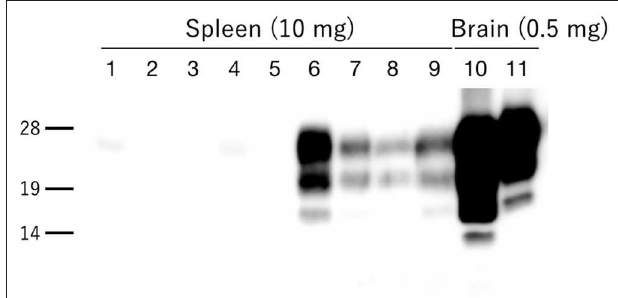
FIGURE 7 | PrP res accumulation in the spleens of H-BSE-infected hamsters. PrP res was detected using mAb 6H4. PrP res signals were detected in the spleens of four individual hamsters infected with the H-BSE prion (lanes 6–9), but not in five individual hamsters infected with the L-BSE prion (lanes 1–5). Brain samples from hamsters infected with L- and H-BSE prions were loaded as positive controls, respectively (lanes 10 and 11). The equivalent tissue quantities loaded per lane are indicated at the top, and the molecular markers are shown to the left of the panel